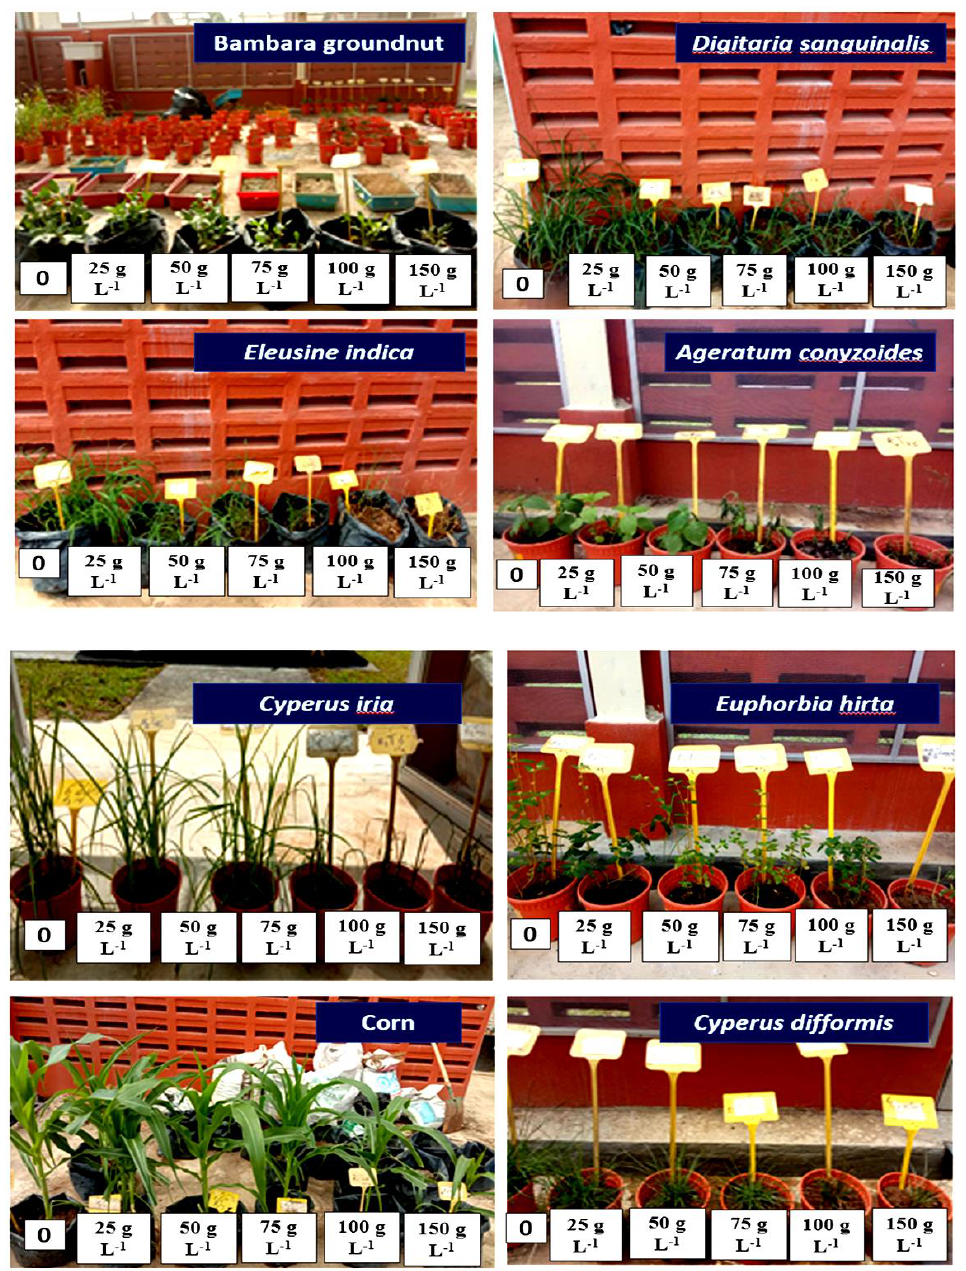
Figure 18. Effect of parthenium leaf methanol extract after post-emergence application on different crops and weeds.